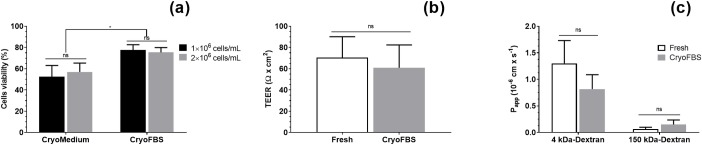
Viability of primary endothelial cells after cryopreservation.(a) Primary endothelial cells (ECs) were concentrated at 1 million cells/mL (black bars) or 2 million cells/mL (grey bars) in either ECs culture medium supplemented with 10% DMSO (CryoMedium) or foetal bovine serum supplemented with 10% DMSO (CryoFBS). Cells were counted after Trypan blue staining, prior to cryopreservation and after thawing. Results are presented as the percentage of the total number of living cells after thawing on the total number of living cells prior to cryopreservation. Data represent the mean values ± SD (n = 4). ANOVA with Tukey’s test: ns: non-significant, * P-value < 0.05. (b) Transendothelial electrical resistance (TEER) of non-cryopreserved P1 ECs (Fresh, white bar) and P1 ECs post-cryopreservation (CryoFBS, grey bar) 9 days after seeding. Data represent the mean values ± SD (n = 8). (c) Permeability values of 4 kDa and 150 kDa FITC-conjugated dextrans through non-cryopreserved P1 ECs (Fresh, white bar) and P1 ECs post-cryopreservation (CryoFBS, grey bar) 9 days after seeding. Data represent the mean values ± SD (n = 4). T-test: ns: non-significant (P-value > 0.05).